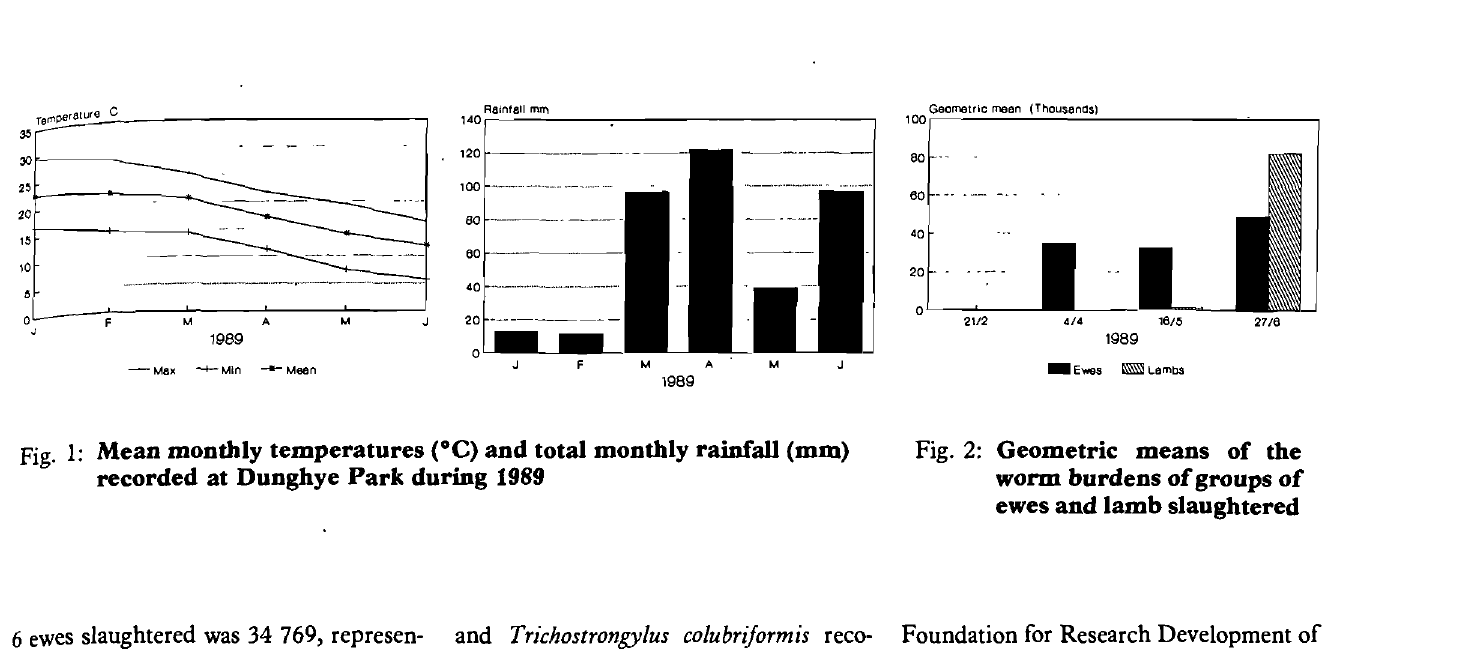
Fig. 1: Mean monthly temperatures (DC) and total monthly rainfall (mm) recorded at Dunghye Park during 1989